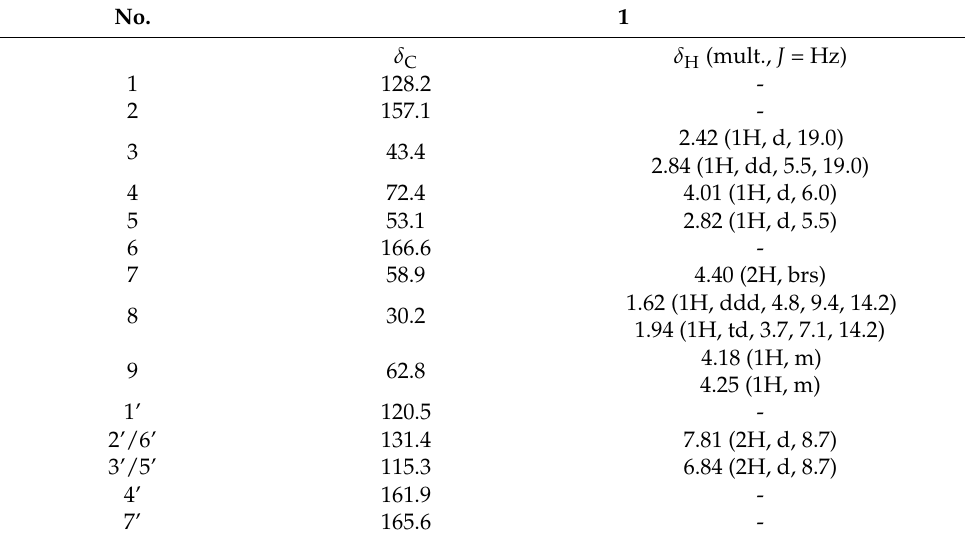
Table 1. Spectroscopic data of compound 1